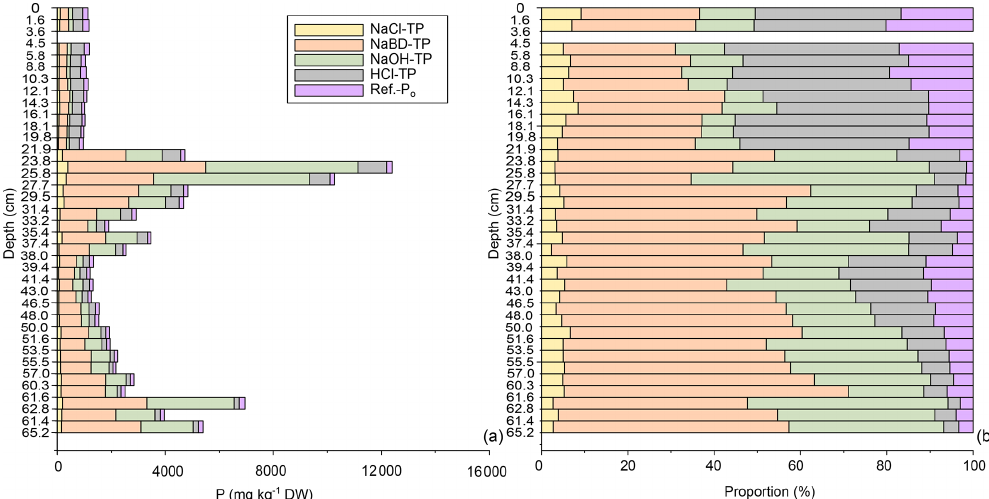
Figure 6. Vertical profile of (a) P fraction concentrations and (b) their proportions of total P in sediments. The y axis (left) refers to the sediment depth of core Burg17-B. Note that the sample between 3.6 and 4.5cm depth was removed from the dataset because the values were extremely higher than any sample data (data not shown), which is abnormal according to XRF P counts at the corresponding depth (Fig. S8b). We attributed this to the result of contamination during the sample